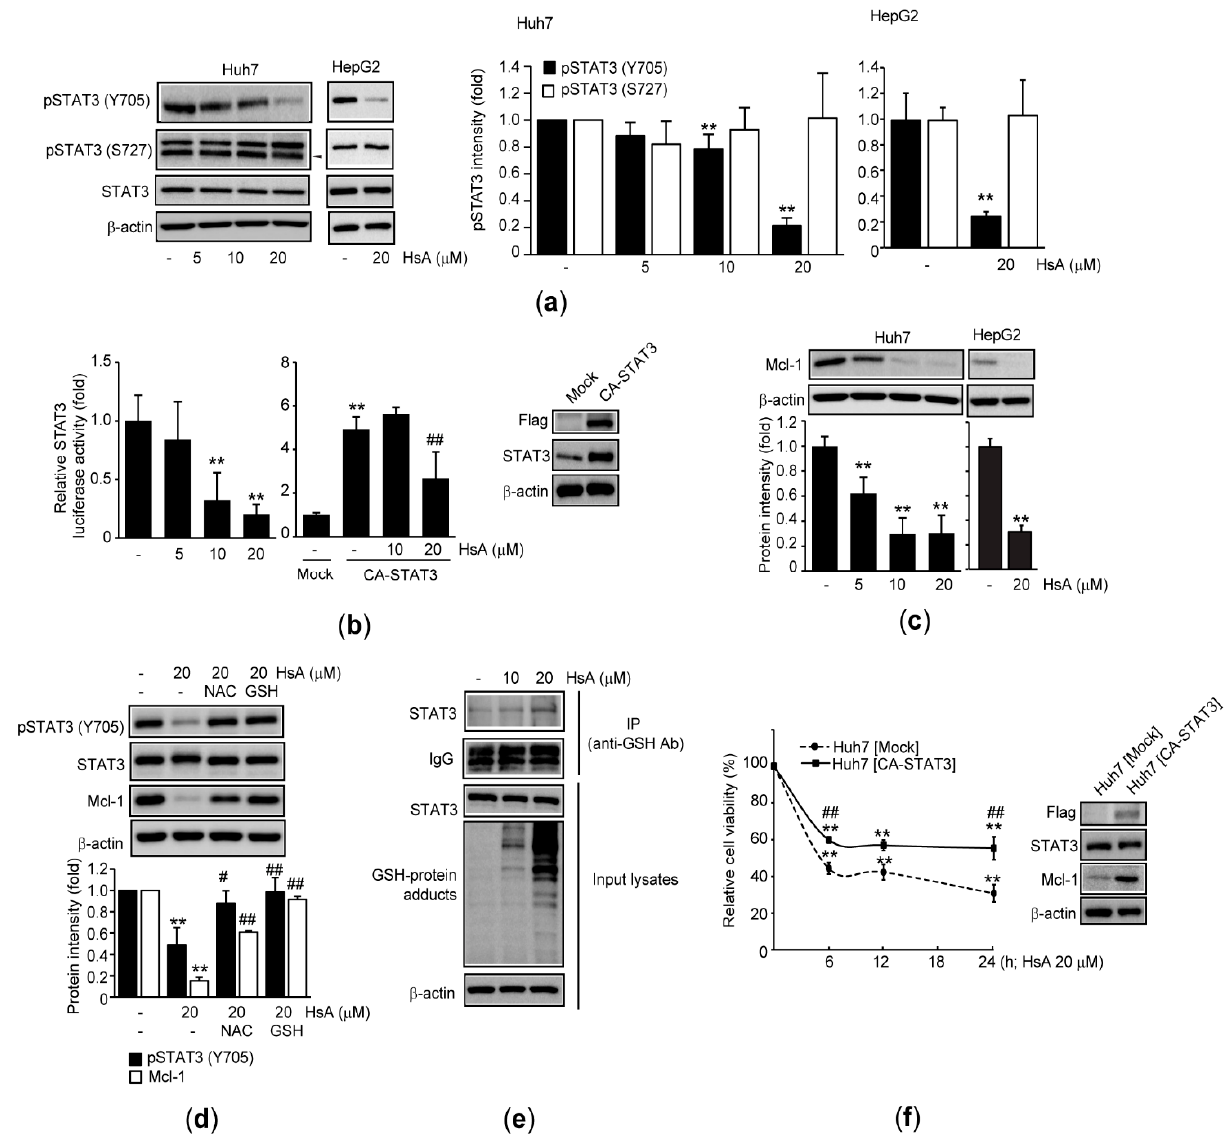
Figure 4. HsA inhibits STAT3 in HCC cells. Huh7 (for a – e ), HepG2 (for a and c ), and recombinant Huh7 cells (for f ) were exposed to 5–20 μ M HsA for 18 (for b ), 24 (for a , c – e ), or 6–24 h (for f ): ( a ) Immunoblot analysis for phosphorylated STAT3 in HsA-treated HCC cells. Arrowhead in immunoblot image indicates a non-specific band (left). Band intensity of phosphorylated STAT3 in Huh7 (middle) and HepG2 (right) was quantified by densitometry; ( b ) Reporter gene assay. Huh7 cells were transiently transfected with pGL4.47[luc2P/SIE/Hygro] alone (left) or in combination with CA-STAT3. Equal amount of pCDNA3.2/V5-DEST was used as mock-transfection (middle and right). Expression of CA-STAT3 was verified by Flag immunoblotting (right); ( c ) Mcl-1 expression in HsA-treated HCC cells (upper). Mcl-1 levels were quantified by densitometry (lower); ( d ) Effect of antioxidants on HsA-dependent STAT3 inhibition. NAC (1 mM)-, or GSH (2 mM)- pretreated Huh7 cells were exposed to HsA (upper). Levels of phosphorylated STAT3 at Y705 and Mcl-1 expression were quantified by densitometry (lower); ( e ) Proteins obtained from HsA-treated Huh7 cells were immunoprecipitated using an anti-GSH antibody, followed by STAT3 immunoblotting. 30 μ g of proteins was used as input control lysates; ( f ) MTT assay was conducted after recombinant Huh7 cells were exposed to HsA (left). Stable expression of CA-STAT3 was verified by Flag immunoblotting (right). ** p < 0.01, significance versus vehicle-treated cells (for a , b -left, c , d , and f ) or mock-transfected cells (for b -middle); ## p < 0.01, # p < 0.05, significance among CA-STAT3-transfected cells (for b -middle), significance among HsA-treated cells (for d ), significance between Huh7 [Mock] and Huh7 [CA-STAT3] (for f -left); pSTAT3, phosphorylated STAT3; IgG, immunoglobulin G; IP, immunoprecipitation; Huh7 [Mock], recombinant Huh7 cells which stably transfected with pCDNA3.2/V5-DEST; Huh7 [CA-STAT3], recombinant Huh7 cells which stably transfected with CA-STAT3.